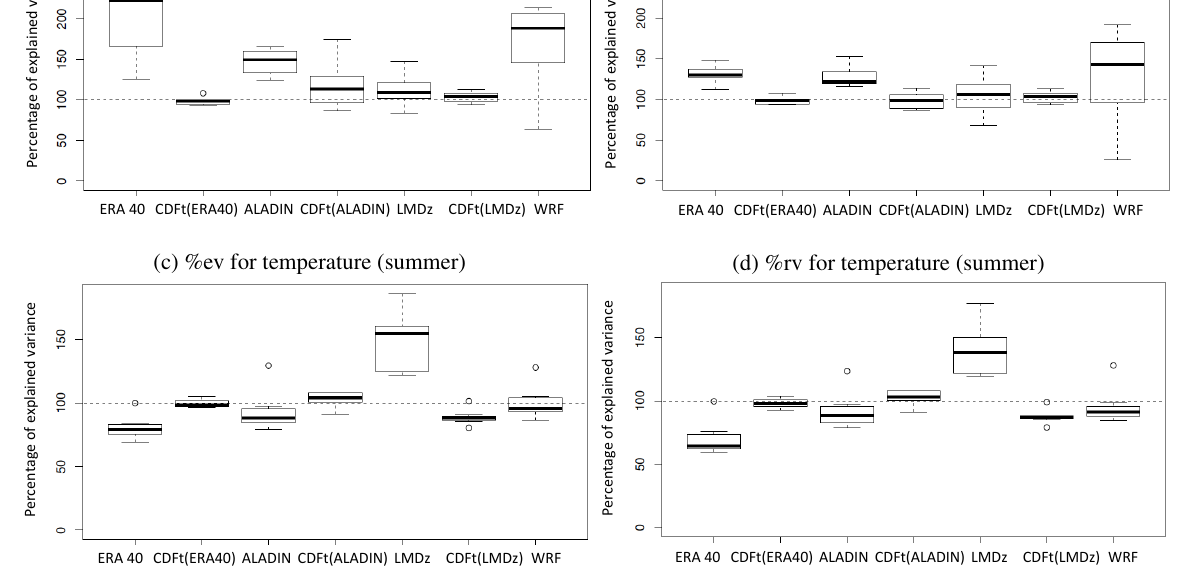
Fig. 4. Same as Fig. 3 but for